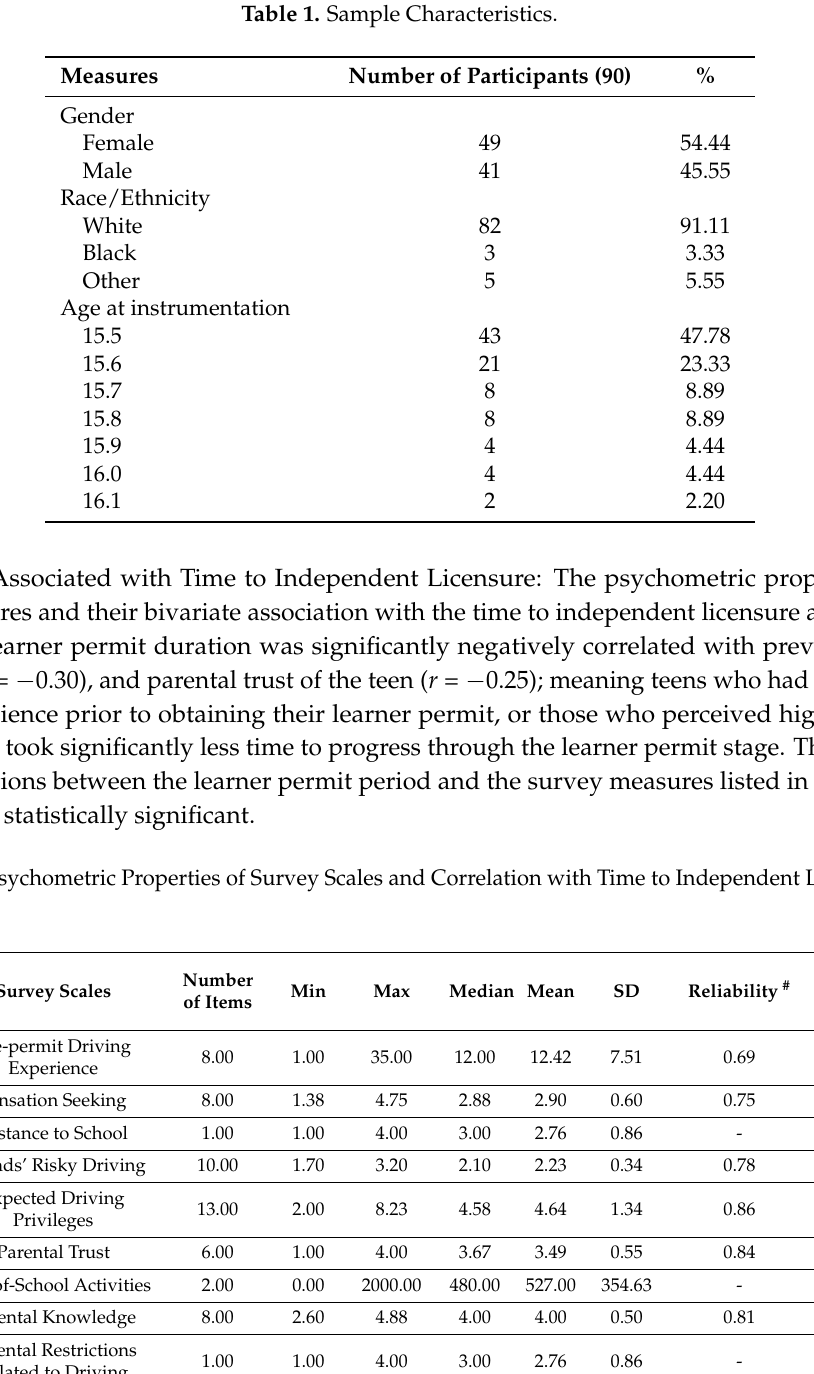
Table 1. Sample Characteristics.